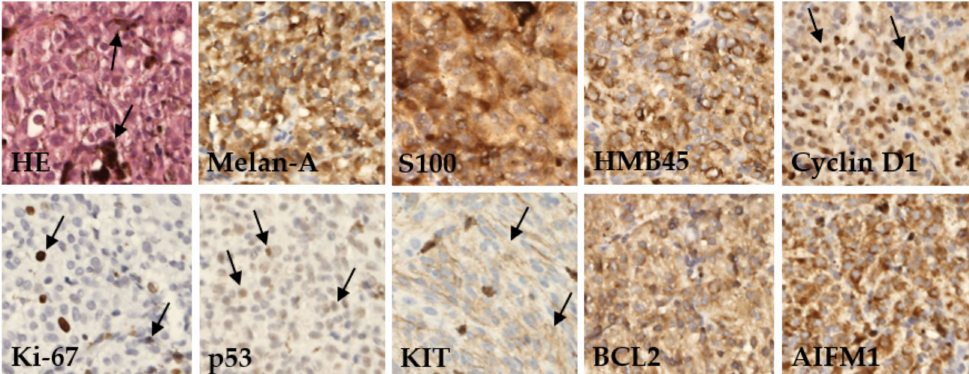
Figure 1. Immunohistochemical detection of various marker proteins’ expression in UM. In basic histological staining with hematoxylin and eosin (HE), the tumor cells showed a variable level of melanin content (arrows). In most cases, the tumors expressed melanoma markers like Melan-A, S100, and HMB45; variable amounts of prognostic markers as anti-apoptotic protein BCL2, Cyclin D1, tumor-suppressor protein p53, AIFM1, KIT protein, and proliferation rate protein Ki-67. Immunoperoxidase technique, diaminobenzidine, 200 ×